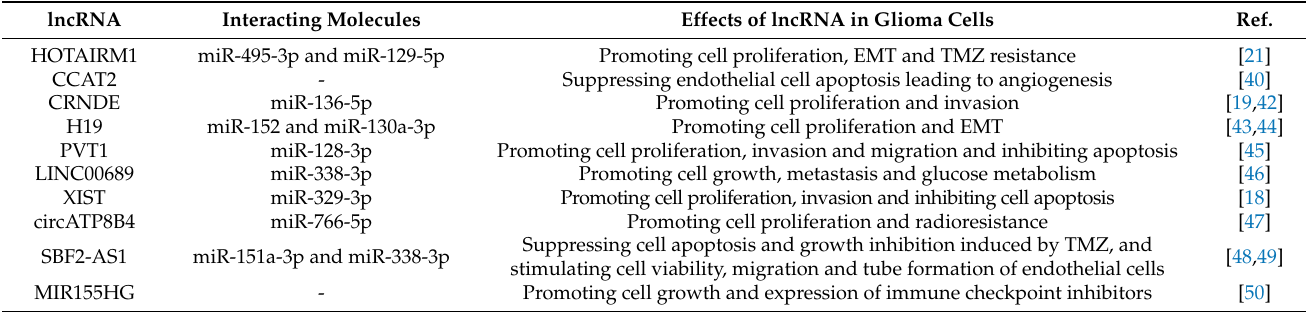
Table 1. Oncogenic lncRNAs upregulated in